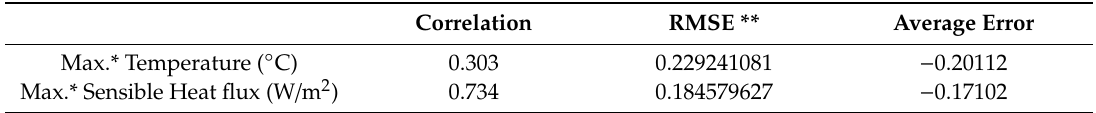
Table 4. Correlation of temperature and Q h vulnerability &RMSE of temperature, Q h vulnerability and mortality. Correlation RMSE **